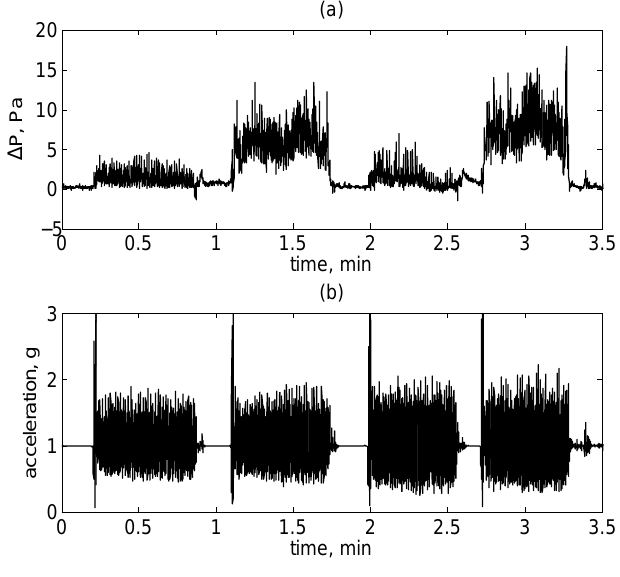
Figure 3. Representation of the readout signal of the activity monitor. (a) Differential pressure generated from air flowing through the Pitot tube during locomotion in outdoors conditions. (b) Acceleration measured during walking outdoors, the peak in the acceleration pattern preceding the walking signal results from a jumping-jack executed to identify the start of a new